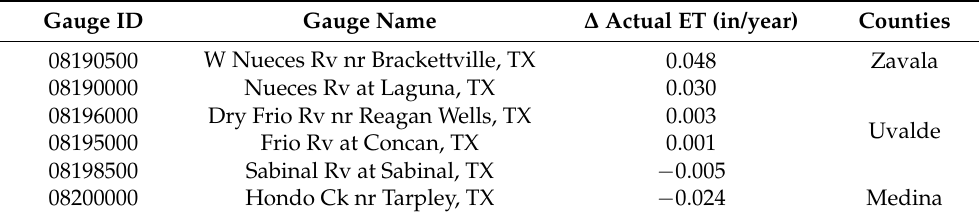
Table 6. Upper NRB change in actual ET from 1979 to 2015 adapted from Szilagyi